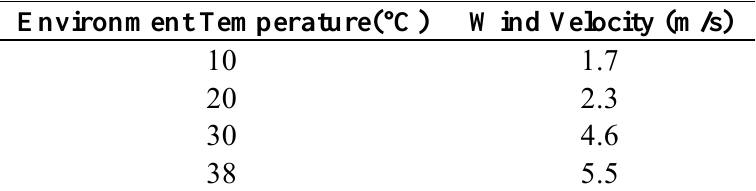
Table 5. Energy-saving cooling strategy.